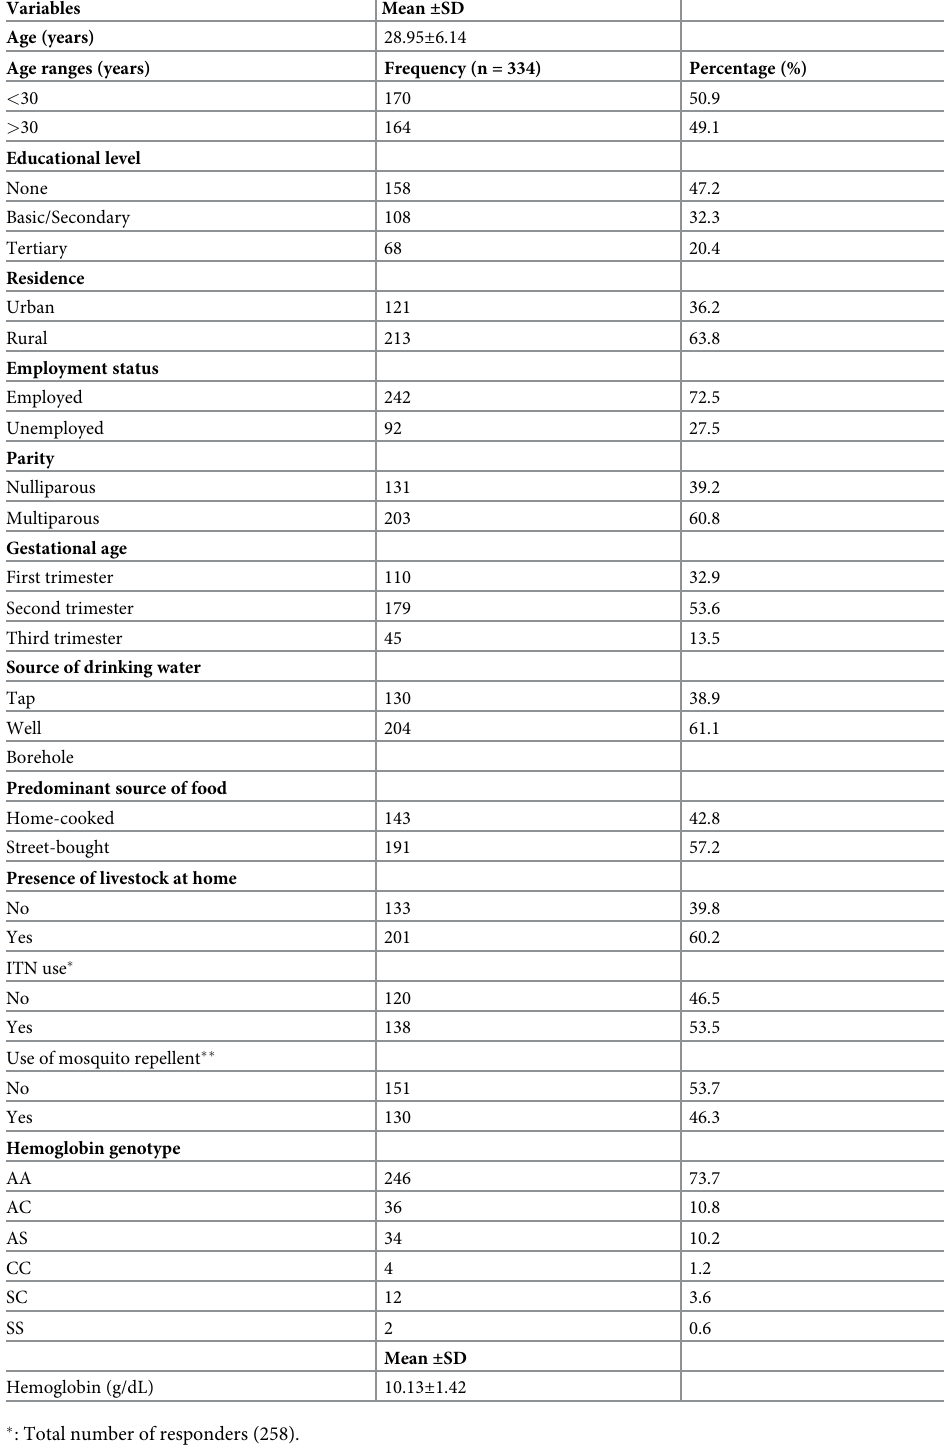
Table 1. Baseline characteristics of the study